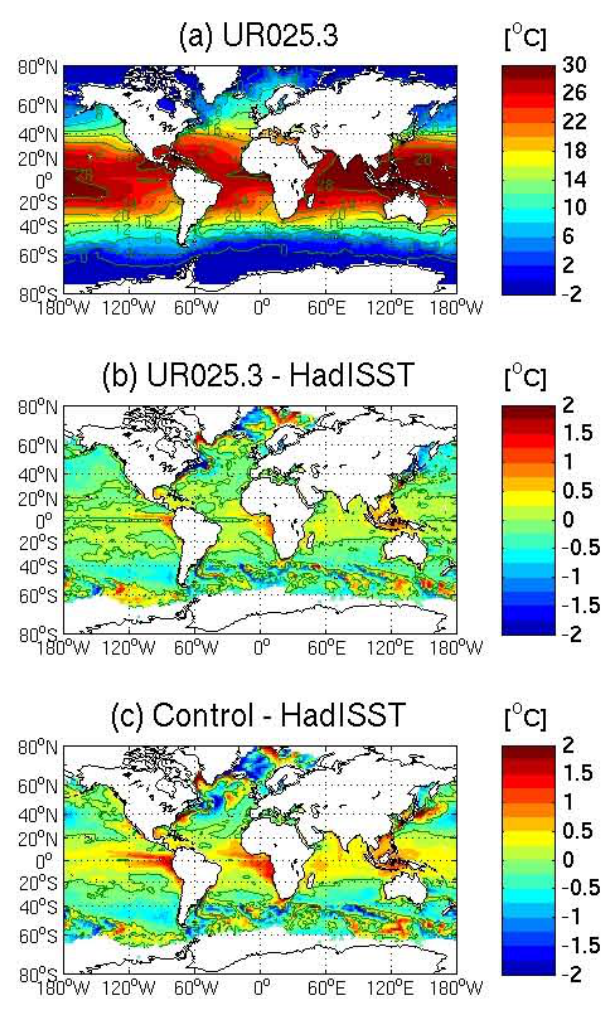
Fig. 1. (a) The mean sea surface temperature (SST) from the UR025.3 reanalysis for 1993–2009, (b) the difference between the mean SST and that from HadISST for the same period, (c) the dif- ference between the equivalent model control run and HadISST through the same